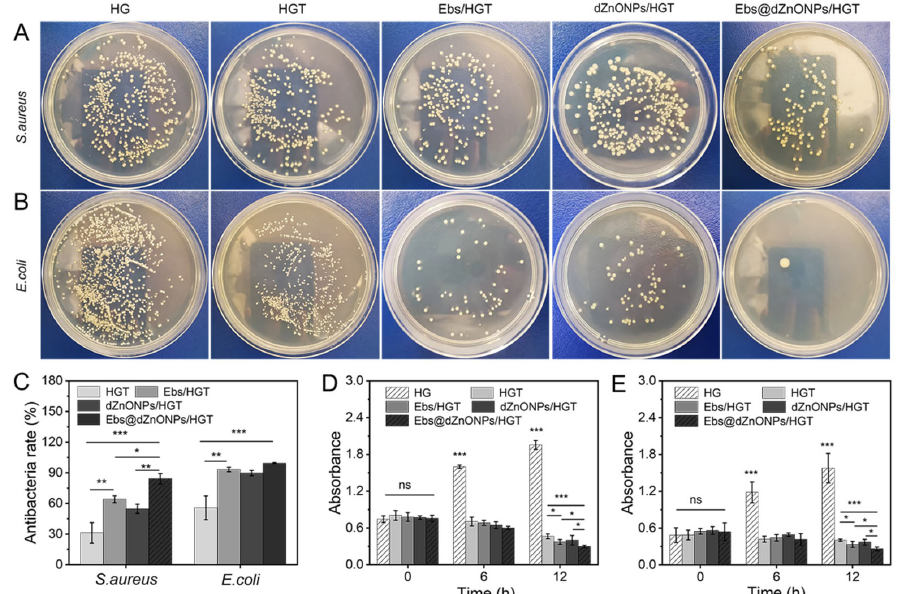
Figure 5. Quantitative analysis of the antibacterial properties of hydrogels: Colony-counting assay of hydrogels against S. aureus ( A ) and E. coli ( B ); ( C ) Antibacterial rate of hydrogels against S. aureus and E. coli (quantitative analysis of colony statistics); Quantitative analysis of photometric method against E. coli ( D ) and S. aureus ( E ). Data are presented as mean ± standard ( n = 3), * means p < 0.05, ** means p < 0.01, *** means p < 0.001.